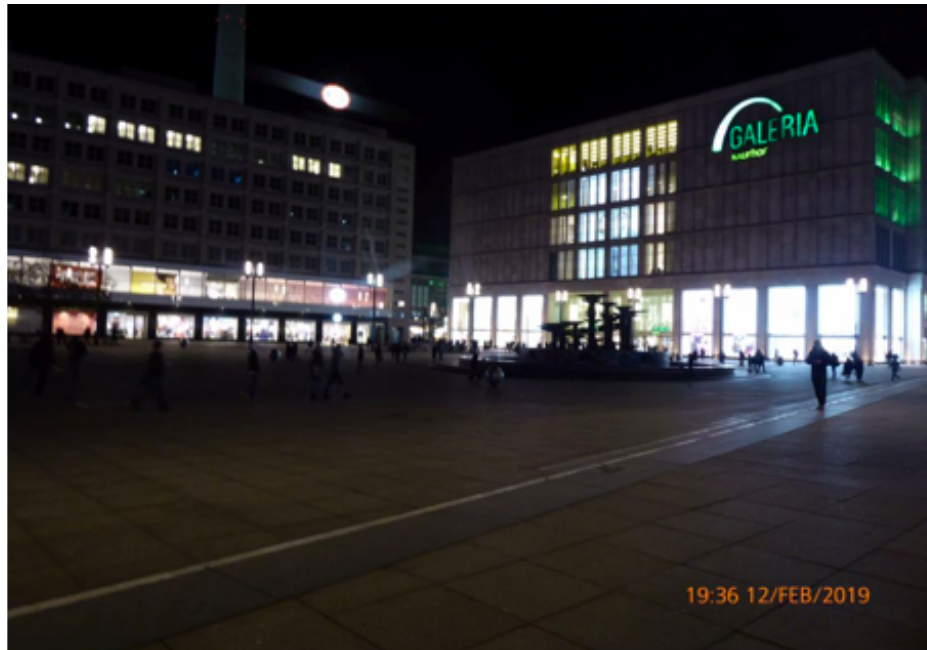
Figure 5. Fountain of Friendship between Nations at the Alexanderplatz in the dark. Source: IRS. be excluded in the measurements of sound, light and distances. For this purpose, we performed 13 mea‐ surements on 4 different days at different times at Alexanderplatz to compare and verify the